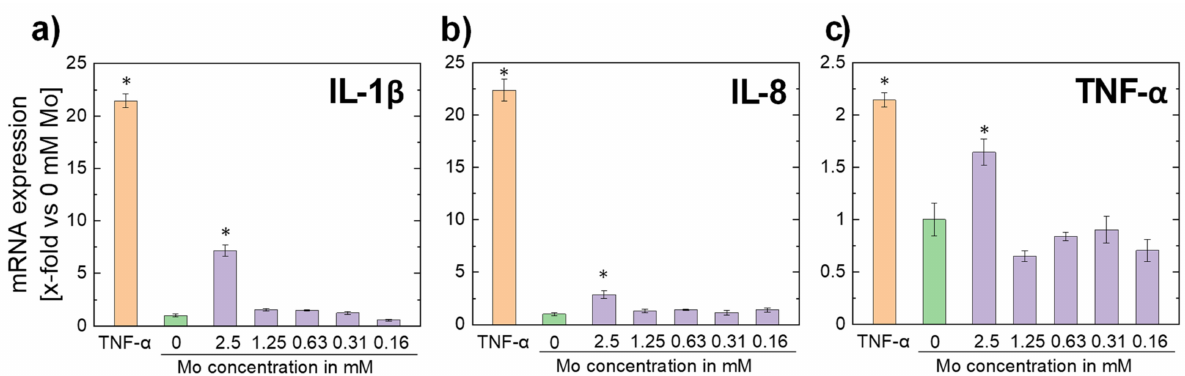
Figure 7. Expression of inflammation markers by human monocytes 24 h after incubation with different Mo ion concentra- tions. Significantly enhanced expression levels of IL-1 β ( a ), IL-8 ( b ), and TNF- α ( c ) were only measured in cells treated with the highest Mo ion concentration (2.5 mM), while all cells incubated with lower Mo ion concentrations did not differ from the untreated control. Incubation with TNF- α (10 ng/mL) served as the positive control ( n = 2, * p < 0.05 vs. 0 mM